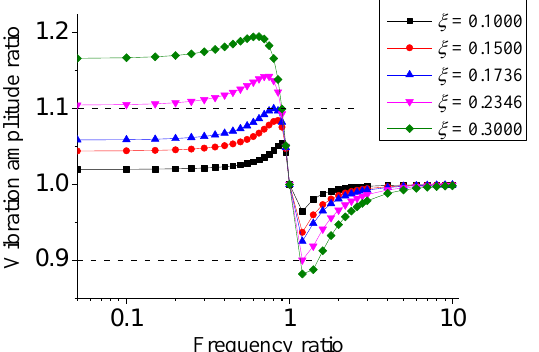
Figure 5. The change curve of vibration amplitude ratios with different damping ratios.